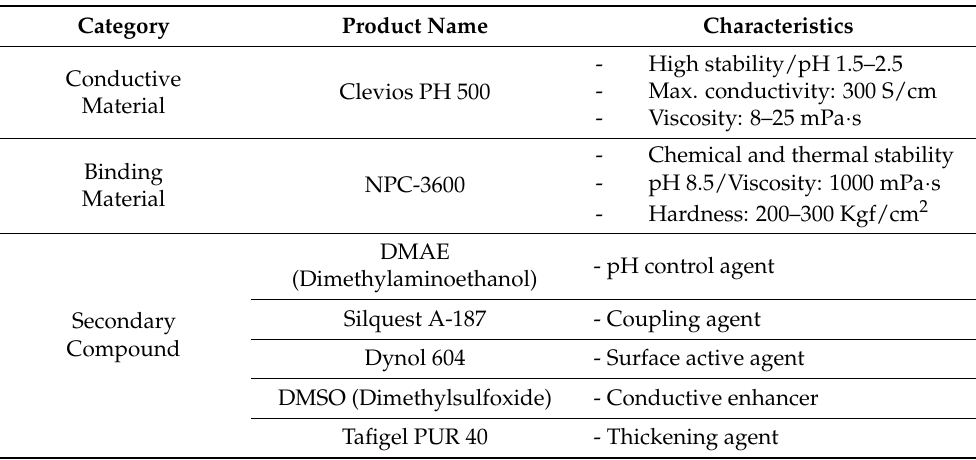
Table 1. Materials used in the conductive